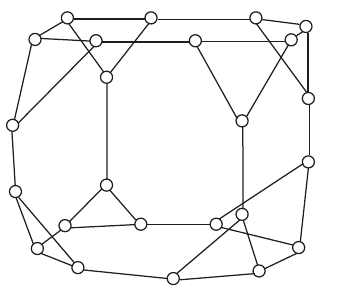
Figure 2: Te 3-dimensional cube-connected-cycle CCC